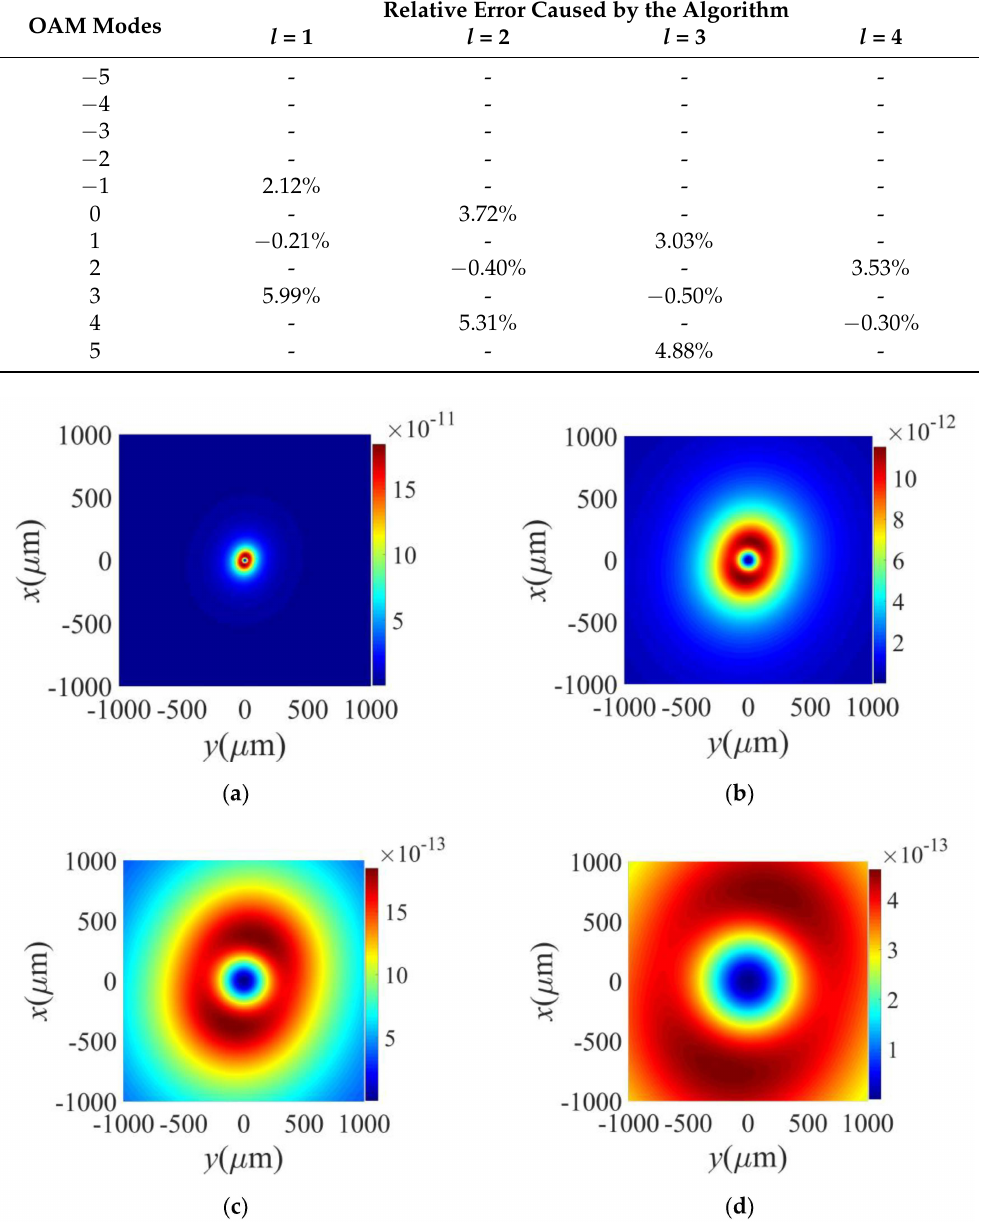
Figure 9. The intensity distribution of the scattered field at different transmission distances, where the topological charge is l = 3 and the other parameters are the same as Figure 5: panels ( a – d ) correspond to the transmission distances of z = 50 µ m, z = 200 µ m, z = 500 µ m and z = 1000 µ m, respectively. Figure 10 shows the spiral spectrum of the scattered field for the receiving plane located at z = 1000 µ m. The scatterer is a homogeneous and isotropic dielectric spherical particle. Compared with Figure 7 and the relative error between them is shown in Table 2, where the detection probability of the OAM modes of the scattered field at z = 50 µ m is set to the true value. It is seen that the maximum relative error is 6.38%, and the maximum magnitude of absolute error is 10 − 3 . Therefore, the position of the receiving plane in the far region does not affect the spiral spectrum of the scattered